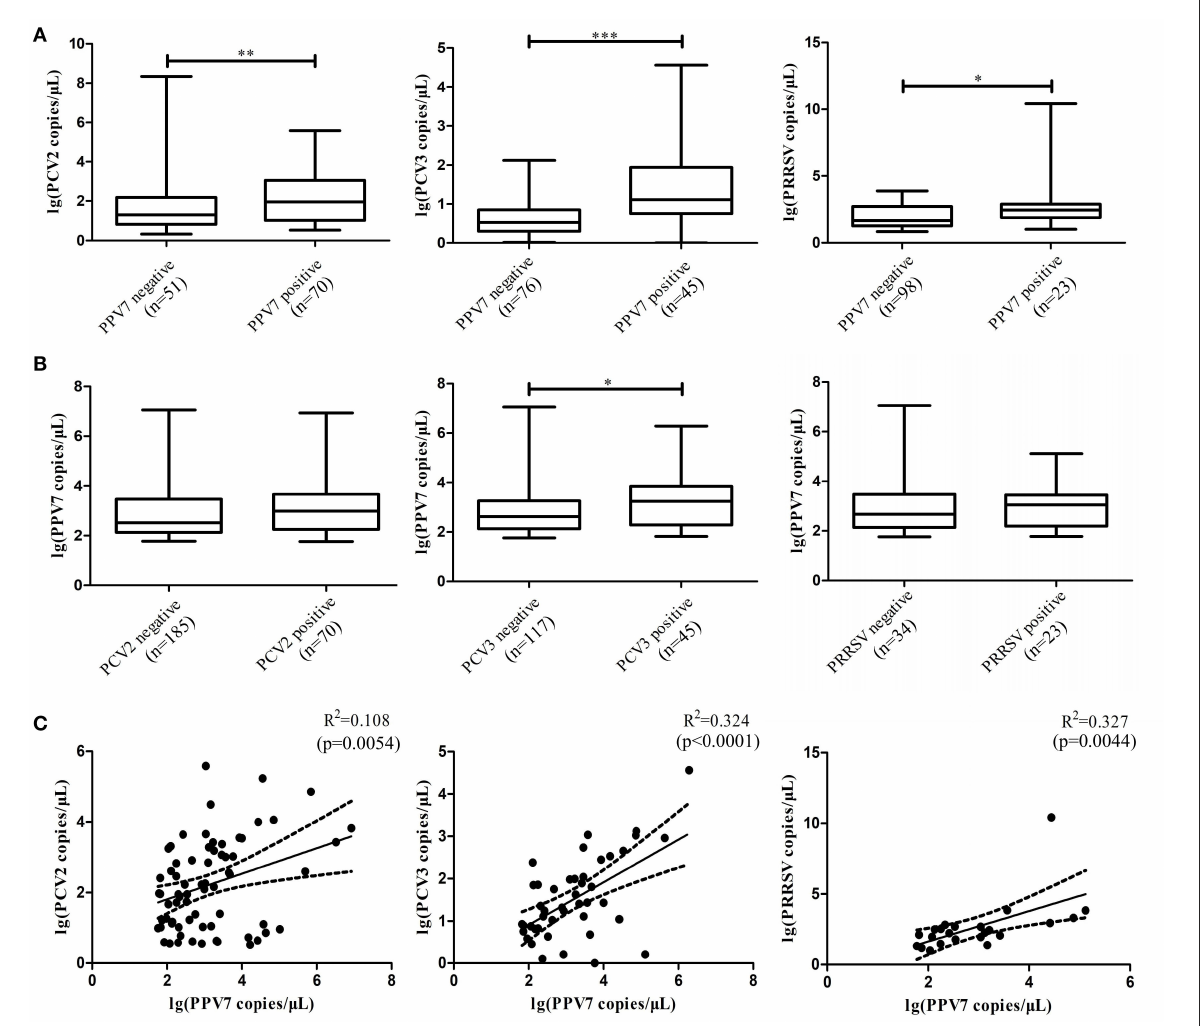
FIGURE1 Boxplot comparison of the real-time PCR copy number of PPV7 with PCV2, PCV3, and PRRSV, and scatterplots with the trends and 95% CI (dashed line) for the copy number of PPV7 with PCV2, PCV3, and PRRSV. (A) Comparison of the real-time PCR copy number of PCV2, PCV3, and PRRSV in POS-PPV7 and NEG-PPV7 serum samples. (B) Comparison of the real-time PCR copy number of PPV7 in POS-PCV2, NEG-PCV2, POS-PCV3, NEG-PCV3, POS-PRRSV, and NEG-PRRSV serum samples. Statistically significant ( p < 0.05) differences are marked with an asterisk. (C) Scatterplots with the trends and 95% CI (dashed line) for the copy number of PPV7 with PCV2 ( p = 0.0054 ), PCV3 ( p < 0.0001) and PRRSV ( p = 0.0044).